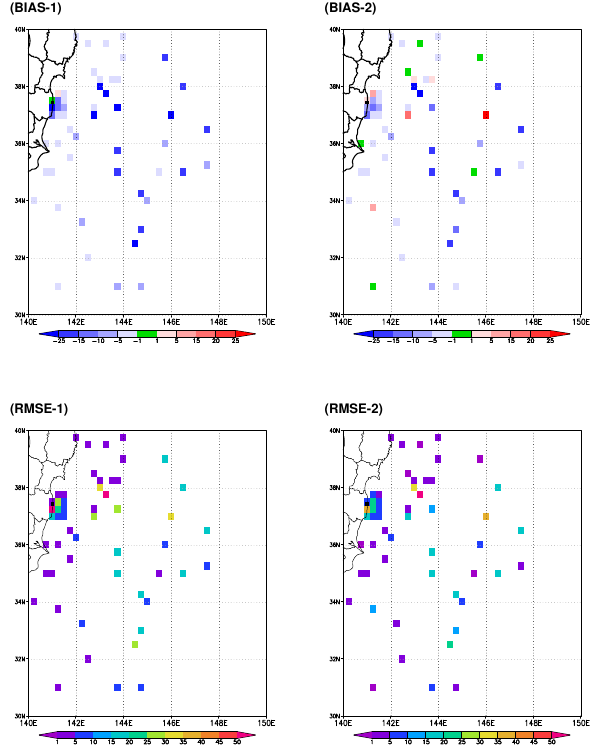
Fig. 11. Gridded distributions of mean error (BIAS) and root mean Figure 11 square error (RMSE) between the simulated and observed 137 Cs surface concentration for the period from 21 March to 6 May 2011, normalized by the measurement errors (see Table 1). Grid resolution is 1/4. The position of FNPP is denoted by a closed square. Left